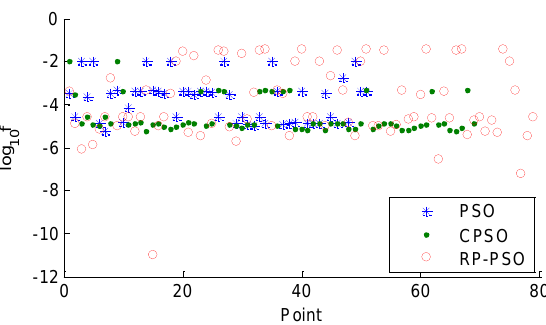
Figure 17. Fitness function value distribution of optimization solutions for three kinds of identification algorithms.